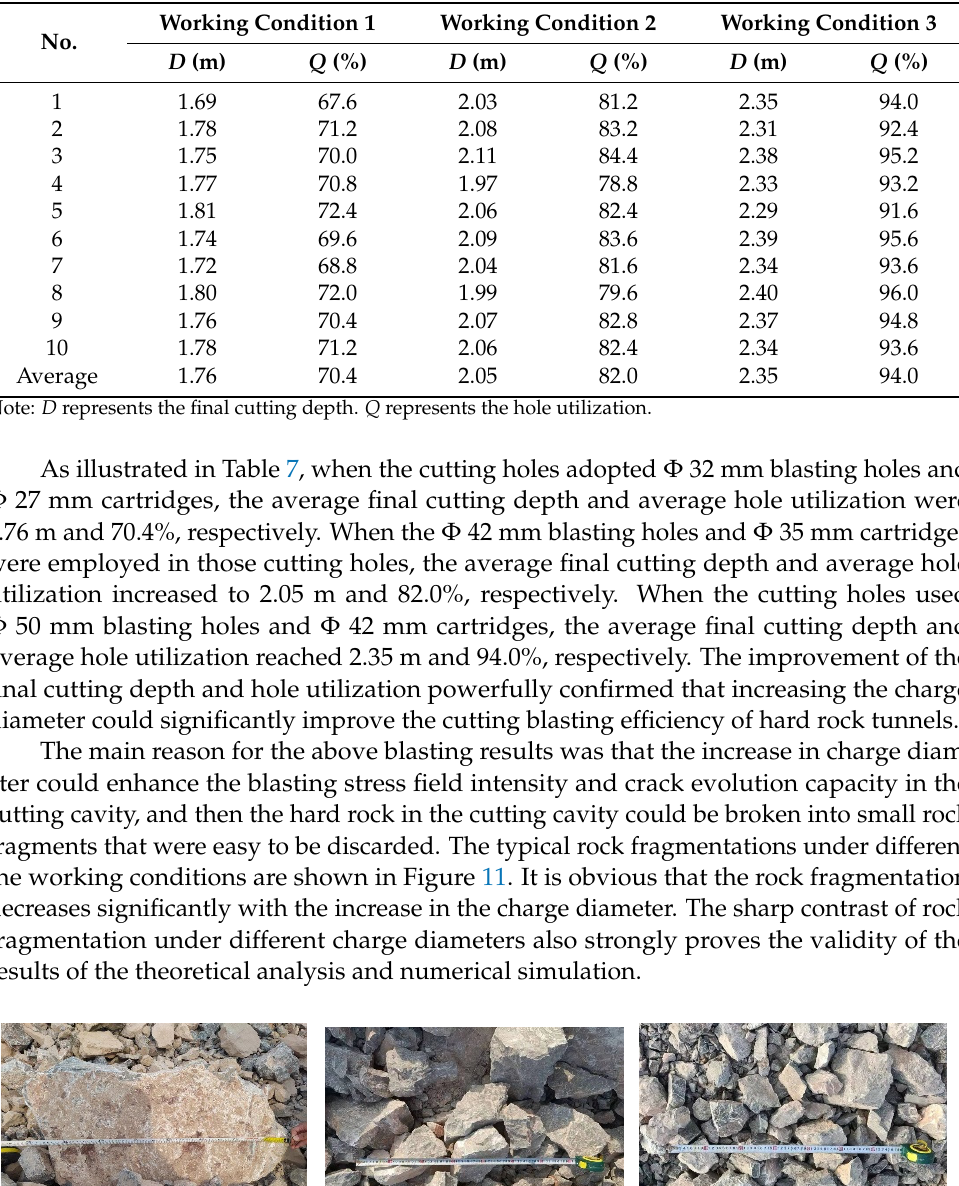
Table 7. Statistics of cutting blasting results.